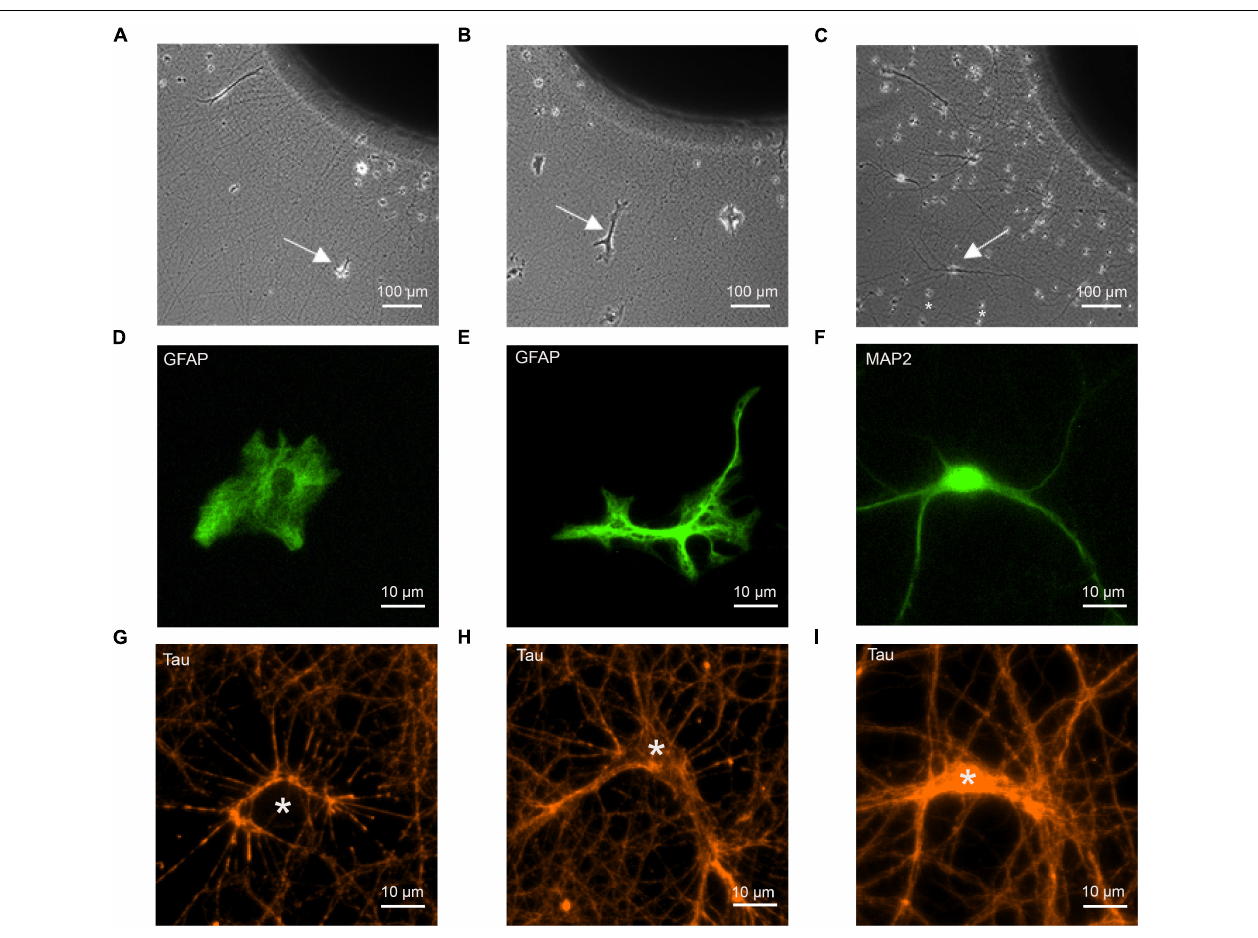
FIGURE 1 | Co-cultures of cortical explants with axon outgrowth and immature astrocytes as target cells. The following target cells were added to explants: (A,D,G) cortical astrocytes; (B,E,H) cerebellar astrocytes; (C,F,I) cortical neurons (control). (A–C) Photomicrographs of co-cultures of cortical explants with axon outgrowth and target cells (white arrows indicate target cells). 12 days of co-culture for target cells. Explants were cultured 5 days before addition of dissociated target cells. In C small cells (marked by *) that occasionally migrated out of the explant (presumably microglia cells) are present in addition to co-cultured neurons. These cells were clearly distinguished from neurons and astrocytes by their different morphology. (D–F) Immunostaining of target cells for GFAP (D,E) and MAP2 (F) to visualize the morphology of target cells. (G–I) Immunostaining of outgrowing axons for tau to demonstrate formation of physical contacts between axons and target cells. White stars indicate the cell bodies of target cells. Cells in (D–I) are not